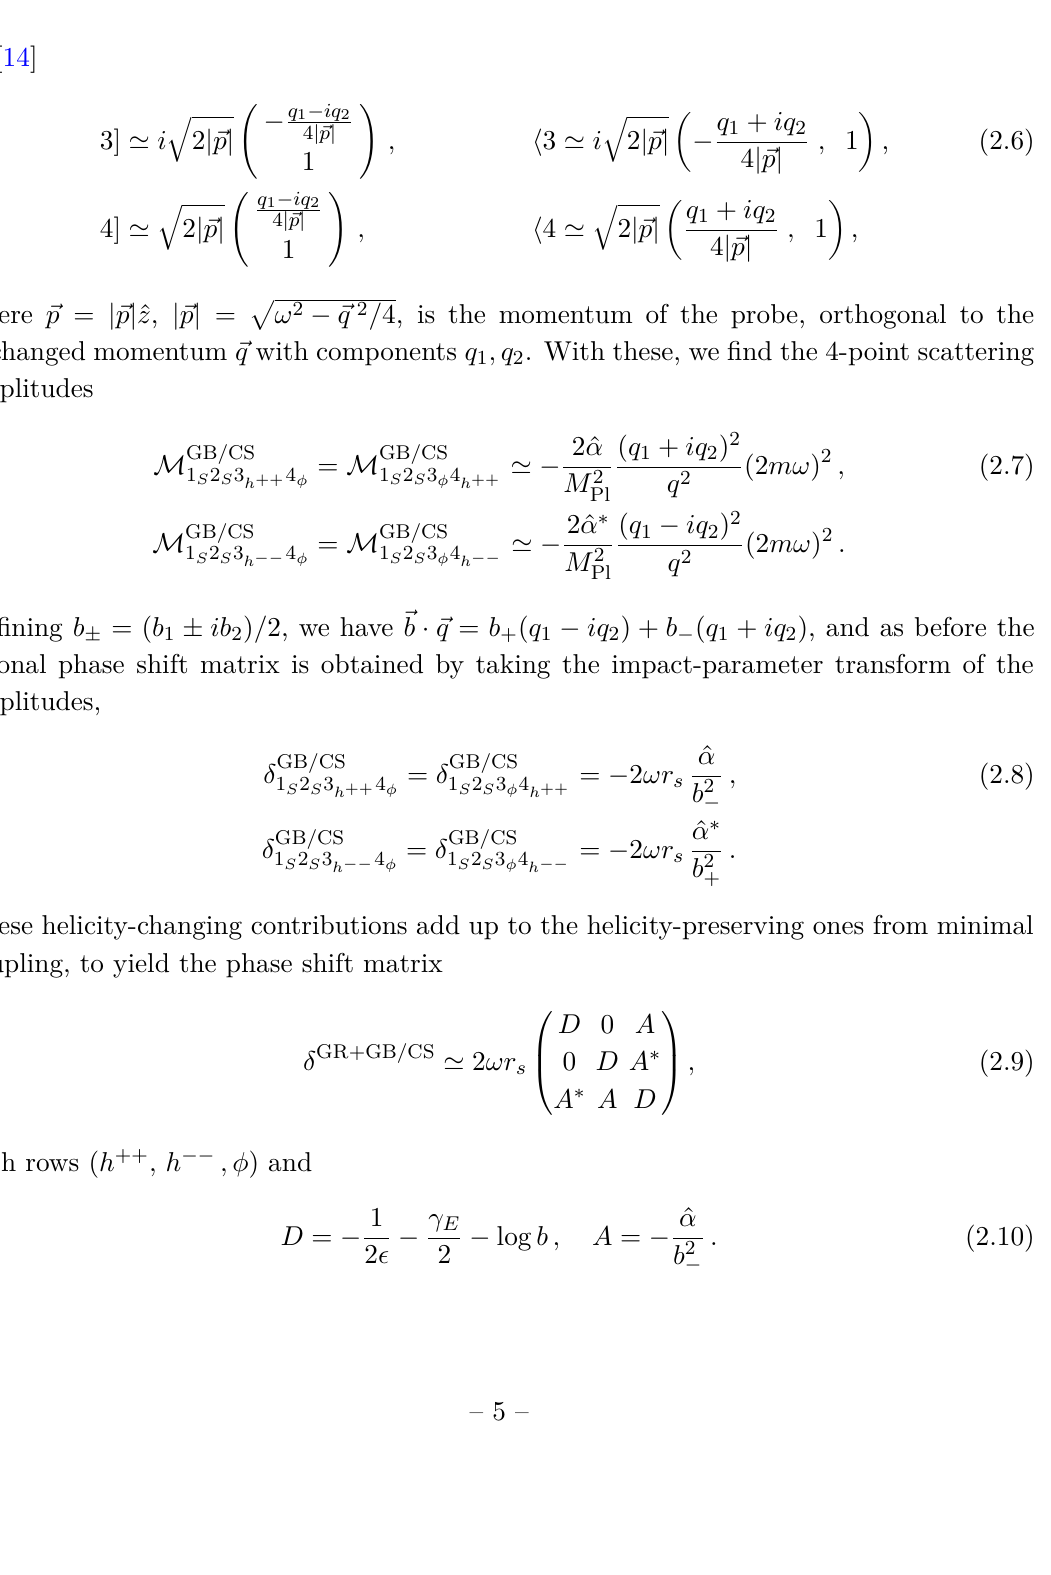
Figure 1 . Leading tree-level diagrams for the eikonal scattering of graviton and scalar against a heavy target. Wiggly lines represent gravitons, dashed lines the massless scalar, and double lines the massive source. The square vertex corresponds to the φRR helicity-changing